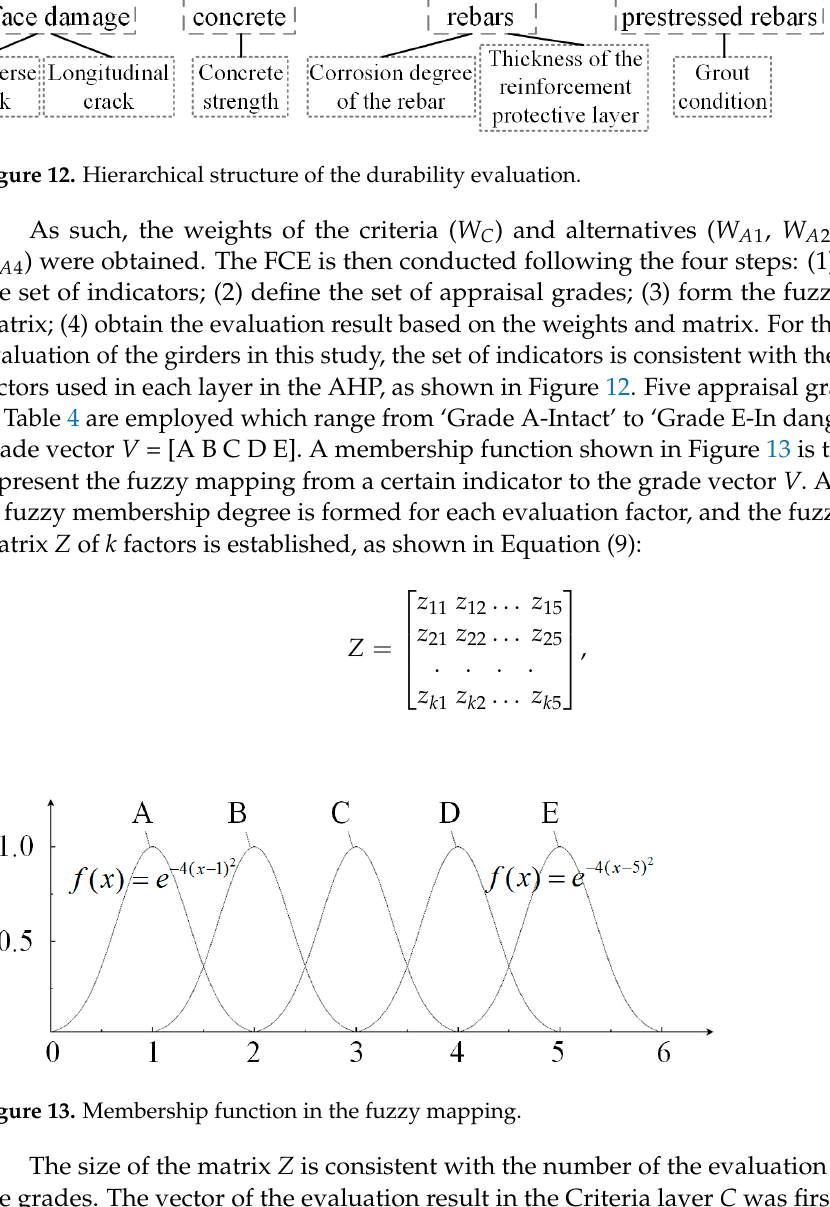
Figure 12. Hierarchical structure of the durability evaluation.